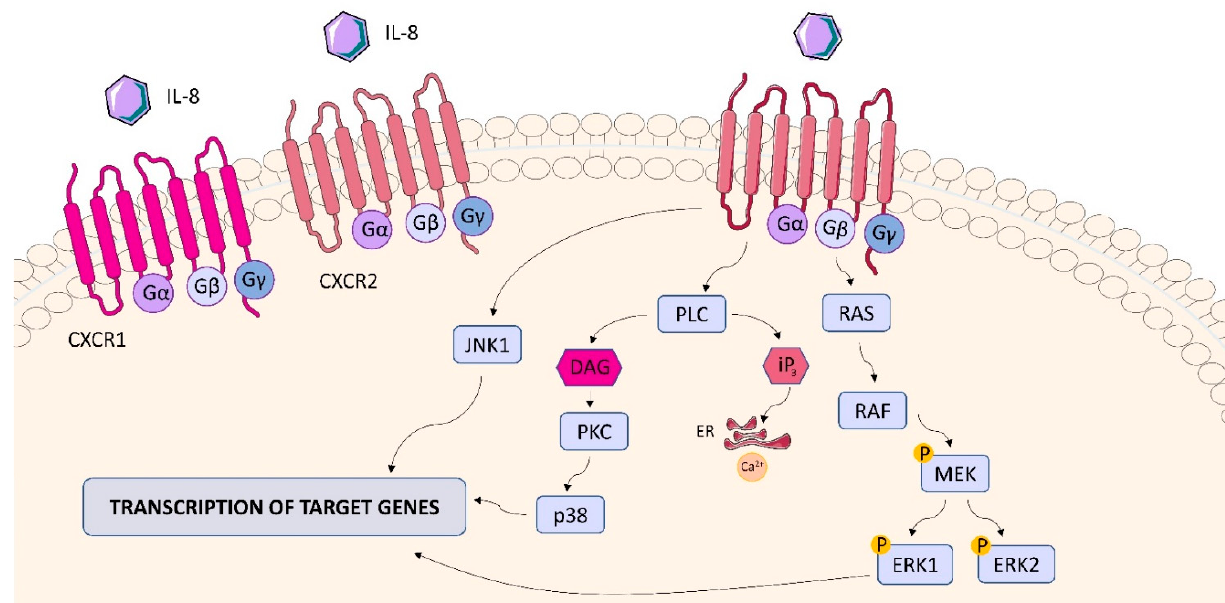
Figure 14. CXCR1 and CXCR2 structure and signaling. The interaction of IL-8 with CXR1/CXCR2 activates ERK1/2, JNK1, and p38 and induces rapid intracellular Ca 2+ mobilization. ERK1/2, JNK1, and p38 stimulates transcription of genes in the cell nucleus, leading to the production of